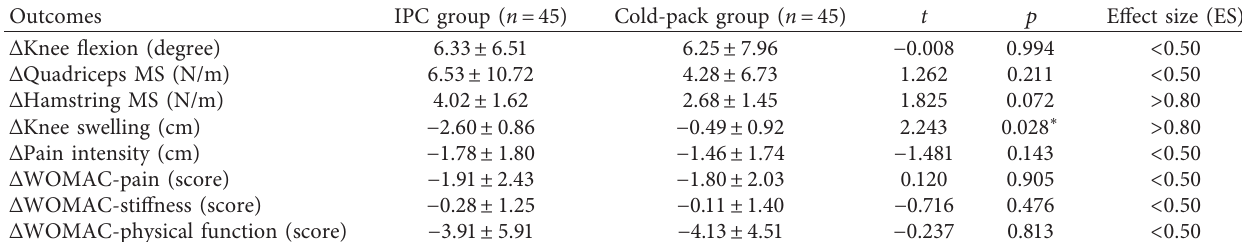
Table 1: Comparison of effect size values of the change in the outcome measures for the IPC and cold-pack groups.